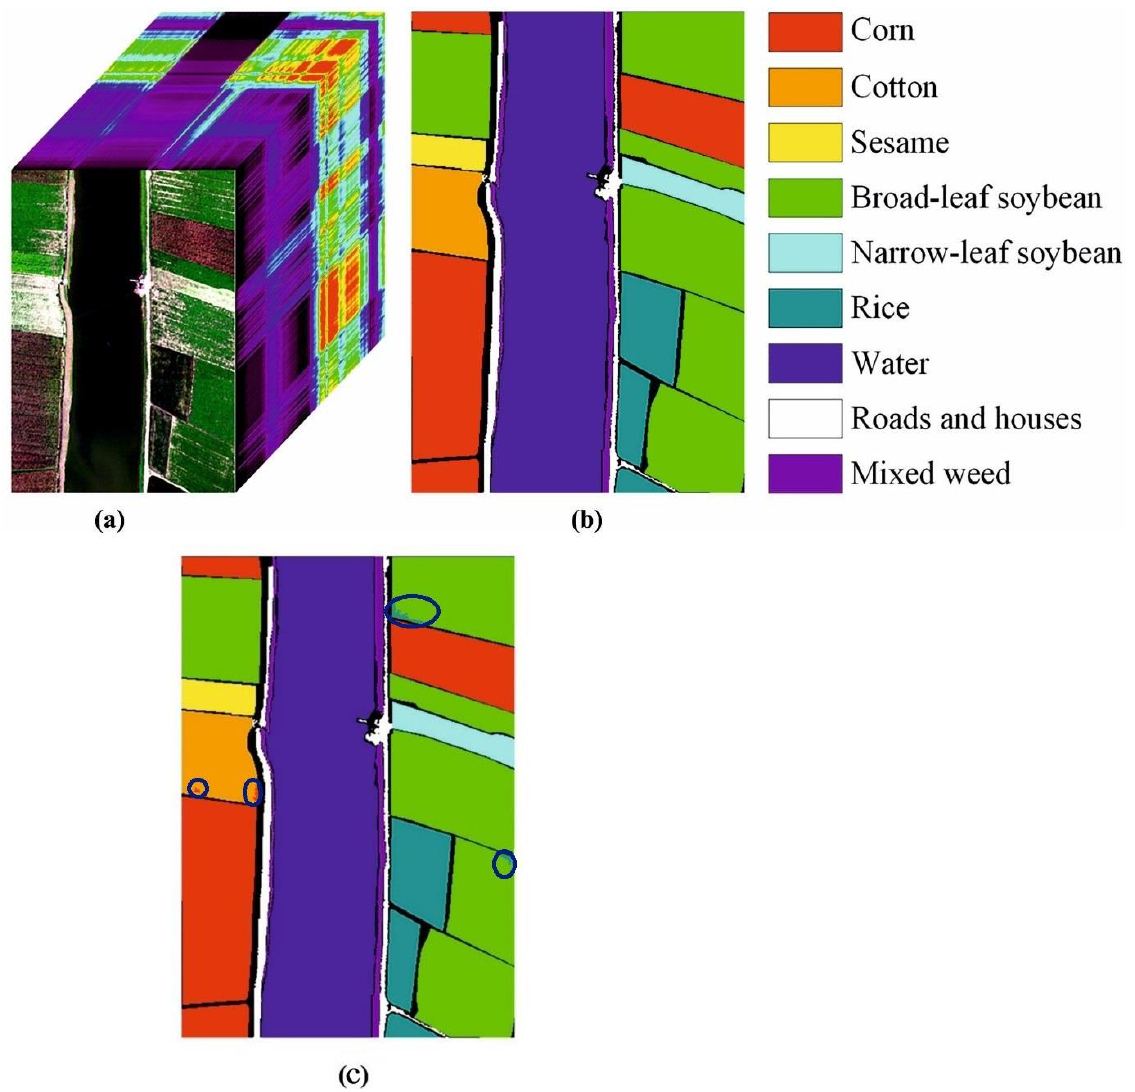
Figure 3. Sample classification result of the SSODTL-CC technique under dataset-1: ( a ) input image, ( b ) class labels, and ( c ) classification output.